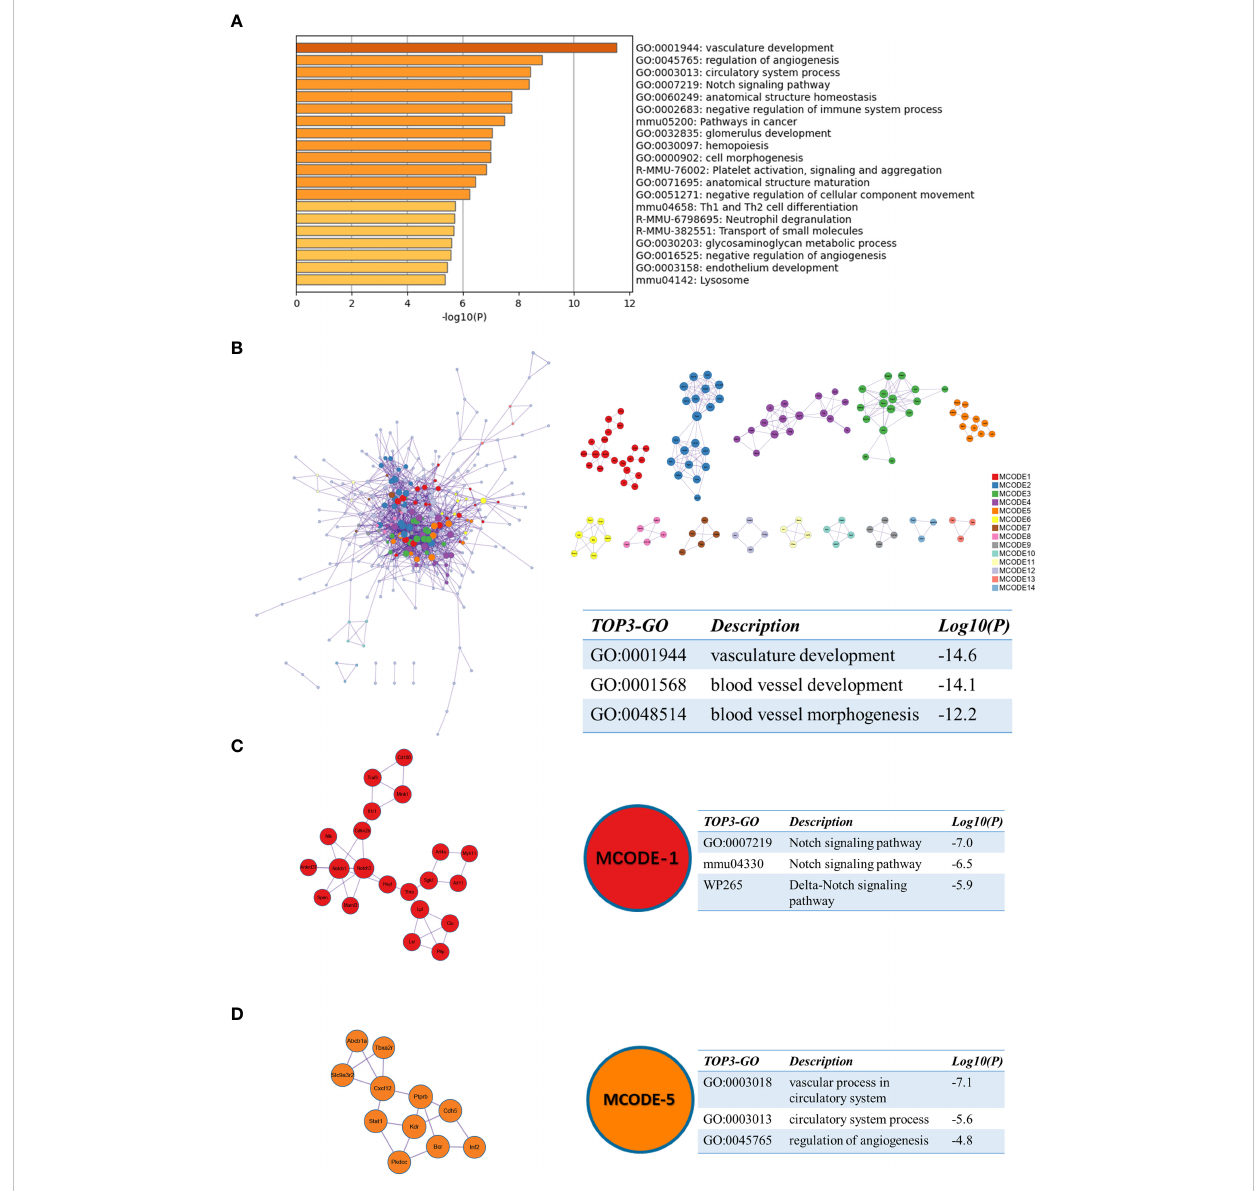
FIGURE 6 Functional enrichment of the sc_S1 on day 3 after tMCAO. (A) The top 20 enriched terms of the sc_S1 on day 3 by Metascape, colored by p-values. (B) Protein-protein interaction network and all MCODE components identi fi ed of the sc_S1 on day 3. (C, D) Representative MCODEs with correlation to enrichment analysis of the